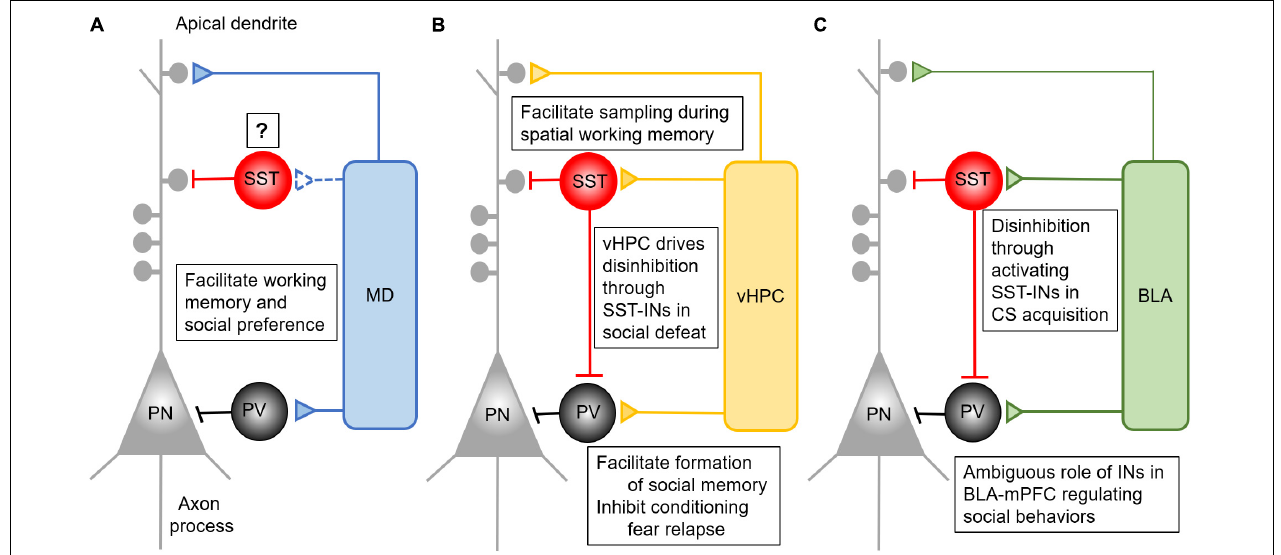
FIGURE 1 | Anatomical and functional connectivity between mPFC and its major long-range inputs. (A) MD afferents form feedforward inhibition in the mPFC by driving the activity of PV- INs. This feedforward inhibition is critical for the performance of mPFC dependent working memory and social interaction, but its connection and role via SST-INs remains to be determined. (B) The vHPC afferents form feedforward inhibition in the mPFC by driving the activity of both PV- and SST- INs. Activation of prefrontal SST-INs by vHPC inputs facilitates spatial working memory performance. The inhibition of conditioning fear relapse is mediated by vHPC activating PV- INs, while vHPC activates SST-INs to inhibit PV-INs in the mPFC. This results in disinhibition of mPFC for the performance of social fear during the social defeat. (C) The BLA afferents form feedforward inhibition in the mPFC by driving the activity of both PV- and SST- INs. Presentation of CS in fear conditioning can activate SST-INs, which inhibit the PV-INs to form disinhibition in the mPFC. This process facilitates the acquisition of CS. Despite the importance of the BLA-mPFC pathway in regulating social behaviors, there is no concrete evidence elaborating the detailed function of PV- and SST-IN in it.